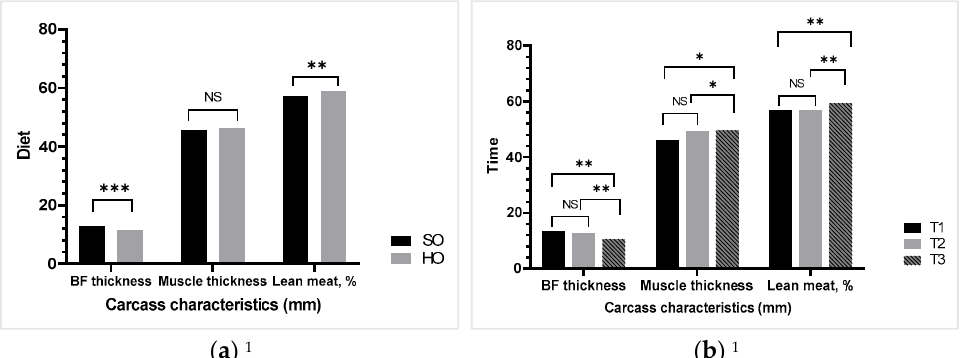
Figure 2. Mean of carcass characteristics of primiparous sows: ( a ) effect of diet (classical diet based on soybean oil, SO, or a rich n-3 FA and lower n-6:n-3 ratio diet based on hemp seed oil, HO) on BW and MBW; ( b ) effect of time (12 h, 10 days, and 21 days) on BW and MBW. 1 Piglog105 version 3.1 portable equipment (SFK Technology A/S, DK-2730 Herlev, Denmark) was used for measuring back-fat thickness and muscle thickness to calculate the lean meat content. Abbreviations: back fat, BF; Time: T1 = 12 h after farrowing, T2 = 10 days, T3 = 21 days; NS: nonsignificant effect; * p < 0.05 significant difference between means, ** p < 0.01 and *** p ≤ 0.001 highly significant difference between means.